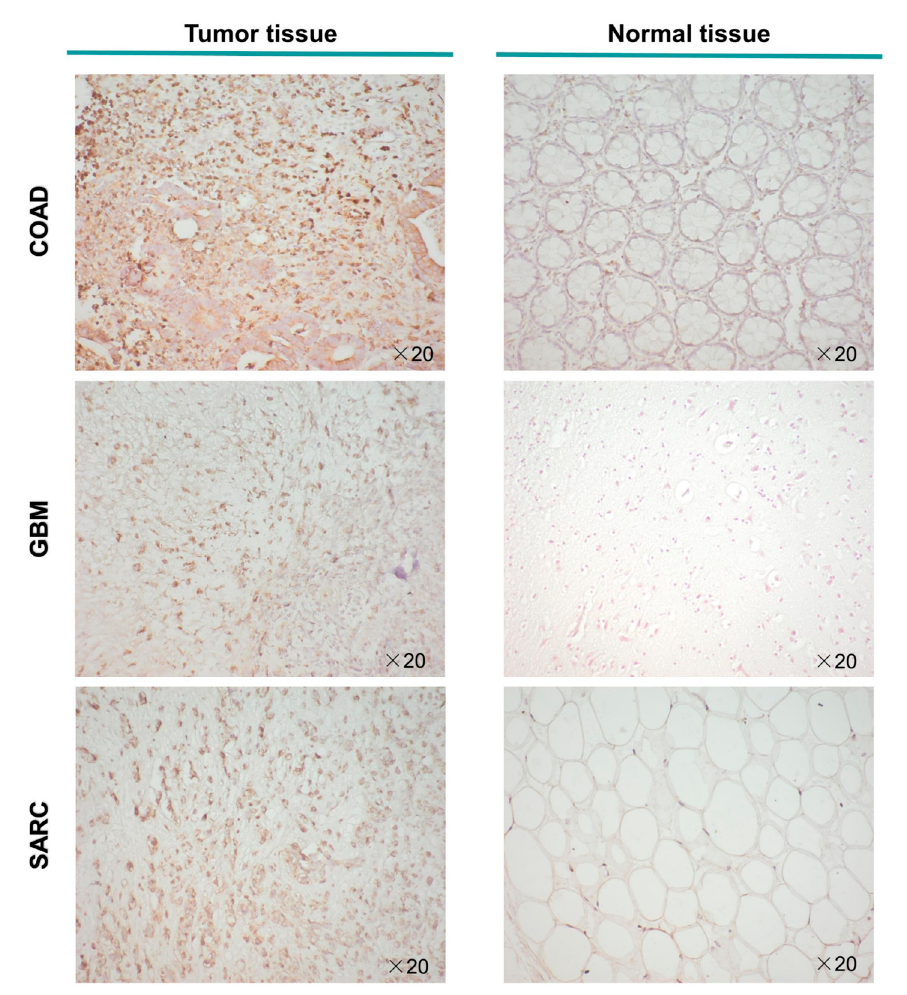
Figure 4. Immunohistochemical staining using patient derived tissue: PLOD3 expression in human COAD, GBM and SARC compared with corelating normal tissue (Colon, brain, and adipose